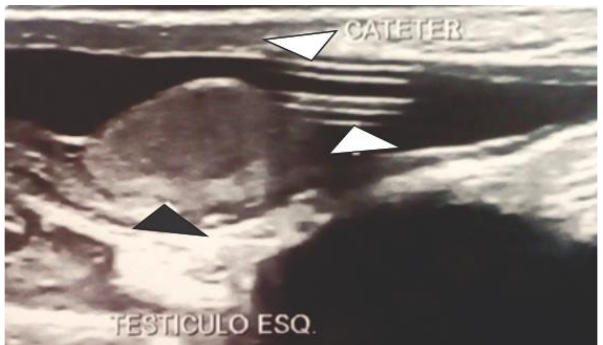
Figure. 3 . Scrotal ultrasound showing the presence of the catheter (white arrows) near the left testicle (black